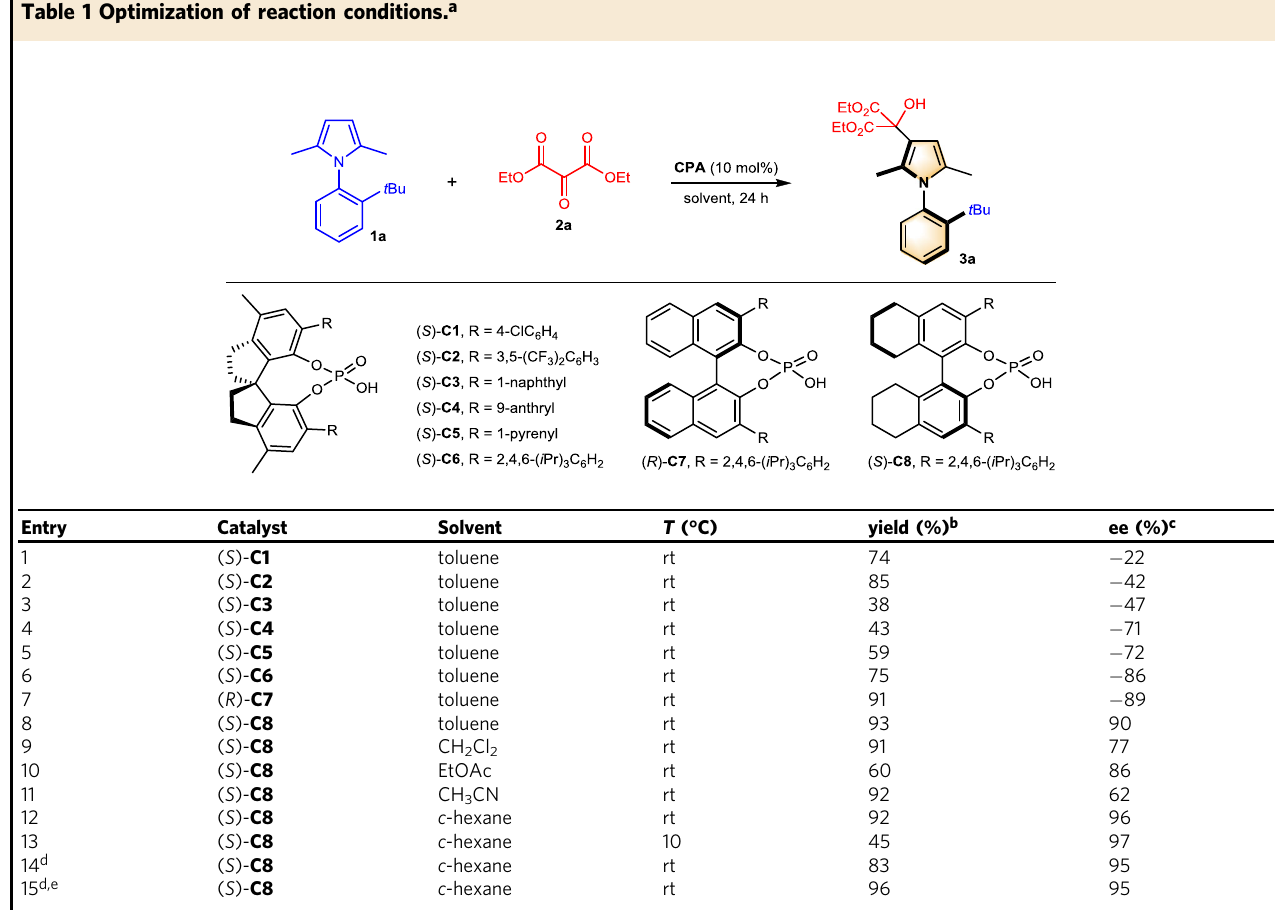
Table 1 Optimization of reaction conditions.